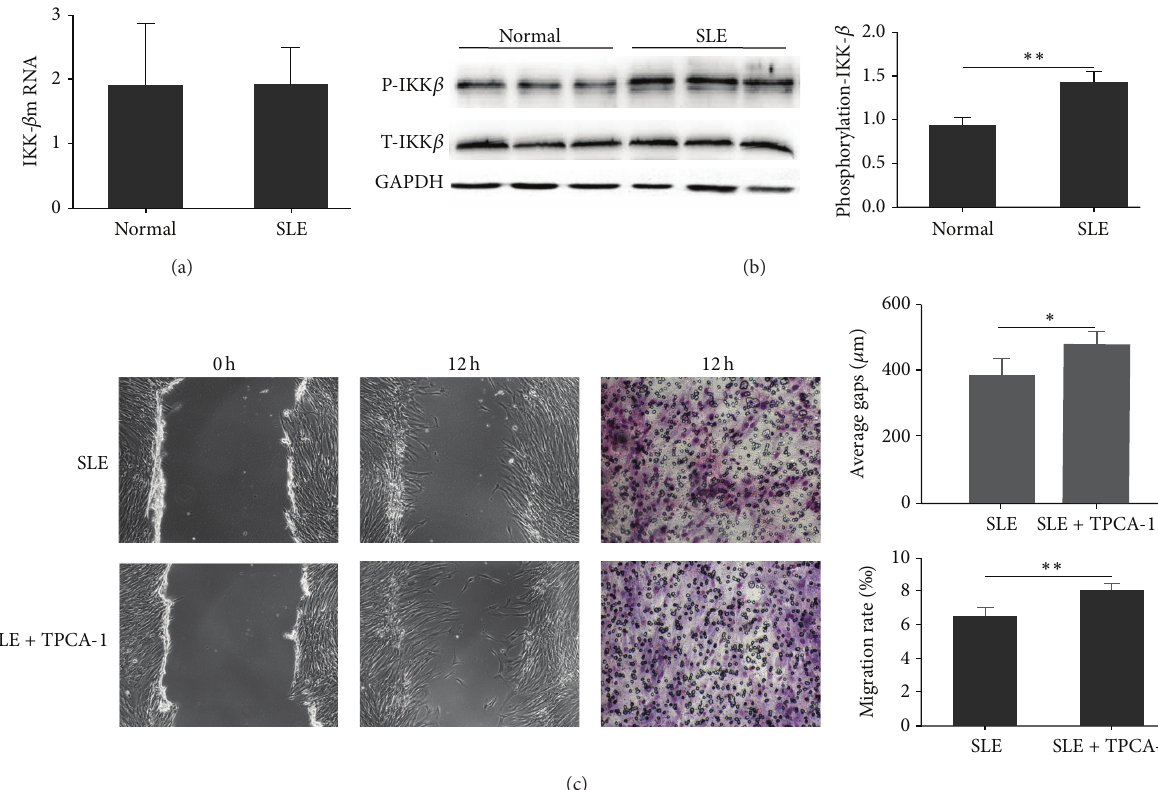
Figure 4: Effect of IKK- 𝛽 in impaired migration capacity of SLE BMSCs. (a) No difference was observed in IKK- 𝛽 mRNA level between SLE patients and normal controls. (b) Phosphorylated-IKK- 𝛽 protein expression of SLE BMSCs (1.38 ± 0.12) was significantly increased. (c) TPCA-1, a selective inhibitor of IKK- 𝛽 , significantly increased the migration rate of SLE BMSCs both in the wound healing ( 𝑃 = 0.03 ) and transwell migration assays. ∗ 𝑃 < 0.05 ; ∗∗ 𝑃 < 0.01